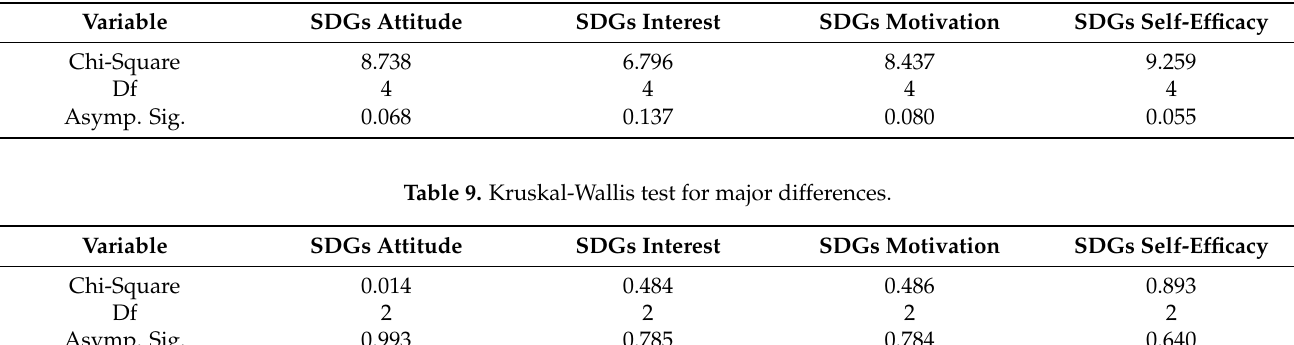
Table 8. Kruskal-Wallis test for grade differences.